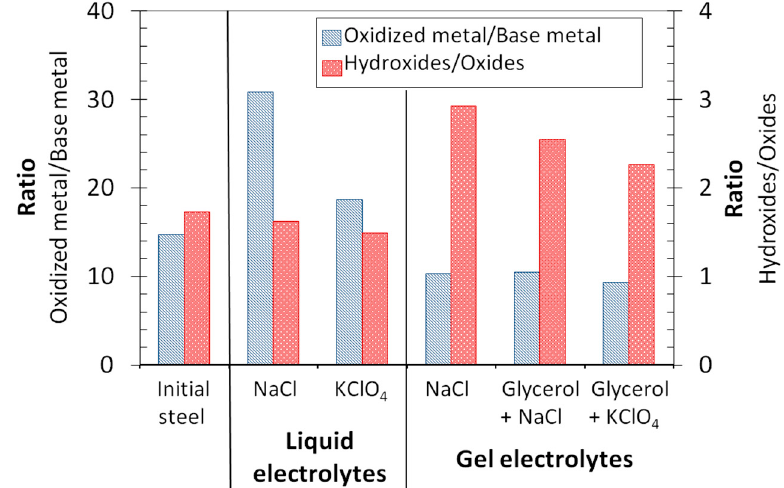
Figure 3. Examples of the deconvolution carried out for the spectral peaks of ( a ) Cr 2p 3/2 , ( b ) Fe 2p 3/2 , and ( c ) O 1s from the X-ray photoelectron spectroscopy (XPS) spectra of the passive films. The peaks shown in the images correspond to stainless steel after being exposed for 1 h to the agar + glycerol electrolyte with 0.5% NaCl.